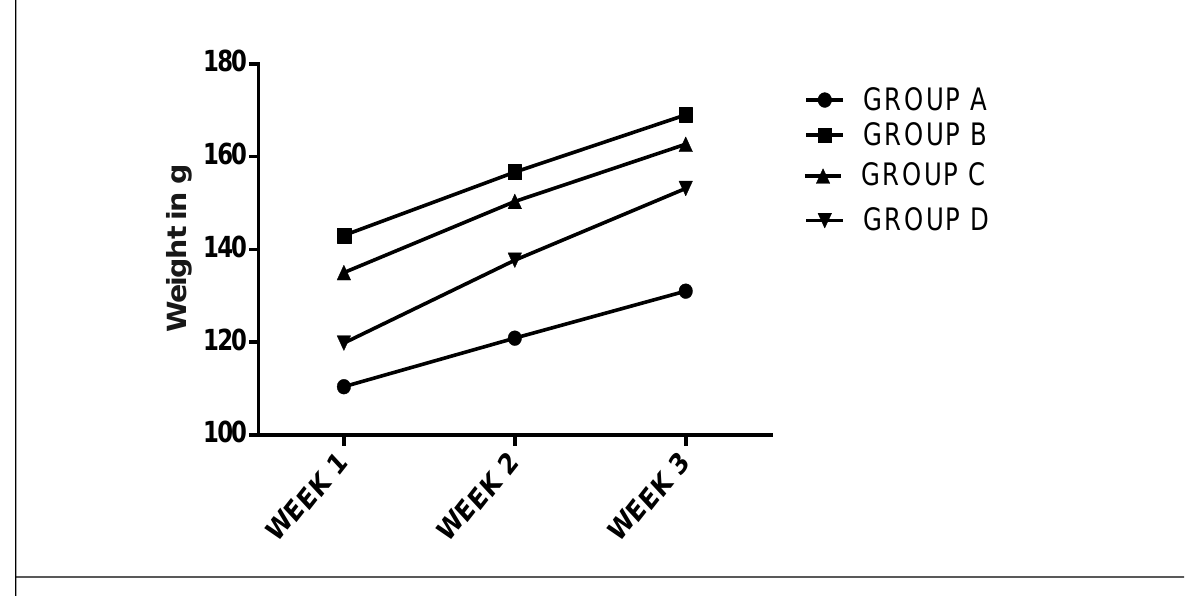
Figure 1: Weight changes observed in rats across groups Note: A line graph showing the change in body weight of rats across the groups. Results are represented as Mean ± Standard Error of Mean (SEM), n = 5 rats in each group. Each value represented as Mean ± SEM, n = 5 readings. Value of p < 0.05 was considered significant. The values with superscript  = significantly different from group A,  = different from group